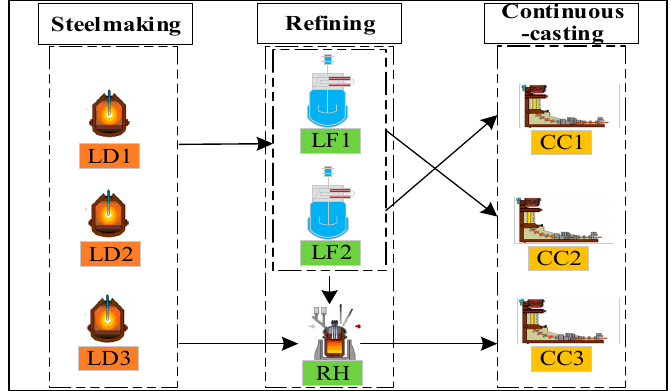
Figure 1. Steelmaking and continuous-casting production.